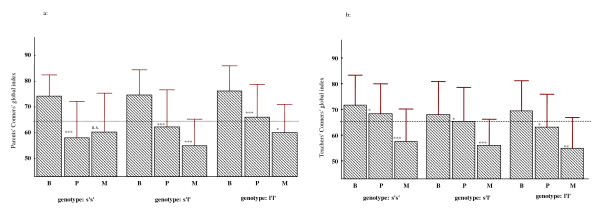
CGI-P and CGI-T scores separated according to child's triallelic 5-HTTLPR genotype at three time points (B, P, and M). Conners' global index scores (± SD) for parents (1a) and teachers (1b) in children with ADHD separated according to their genotype in the 5-HTTLPR of the serotonin transporter gene (SLC6A4) during baseline evaluation (B), treatment with placebo (P) and treatment with methylphenidate (M). Dashed line represents the threshold for clinical significance on the Conners' scales (≥ 65). Asterisks indicate the levels of significance of the differences in CGI scores between different assessments (B vs. P and P vs. M). ***: p < 0.001, **: p < 0.01, *: p < 0.05, ns = non significant.